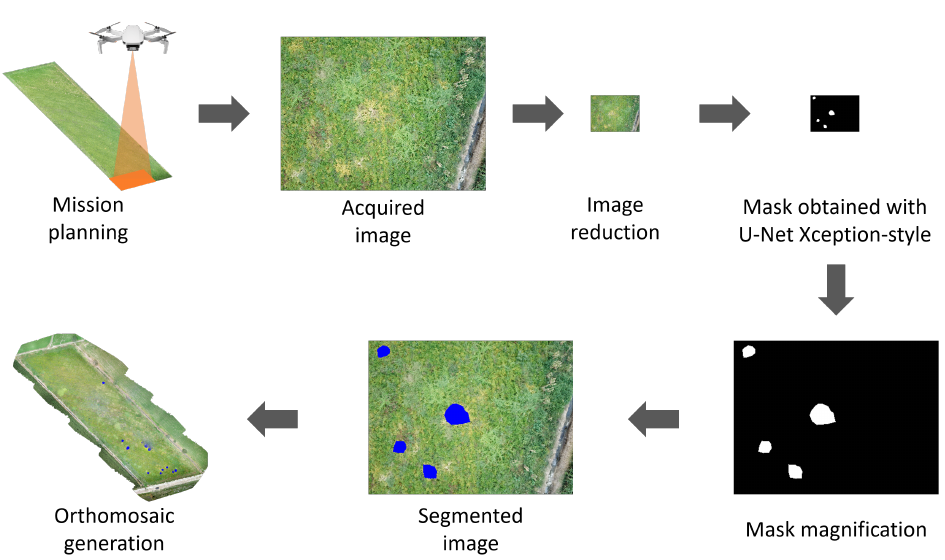
Figure 5. Proposed method for Cuscuta spp. identification.